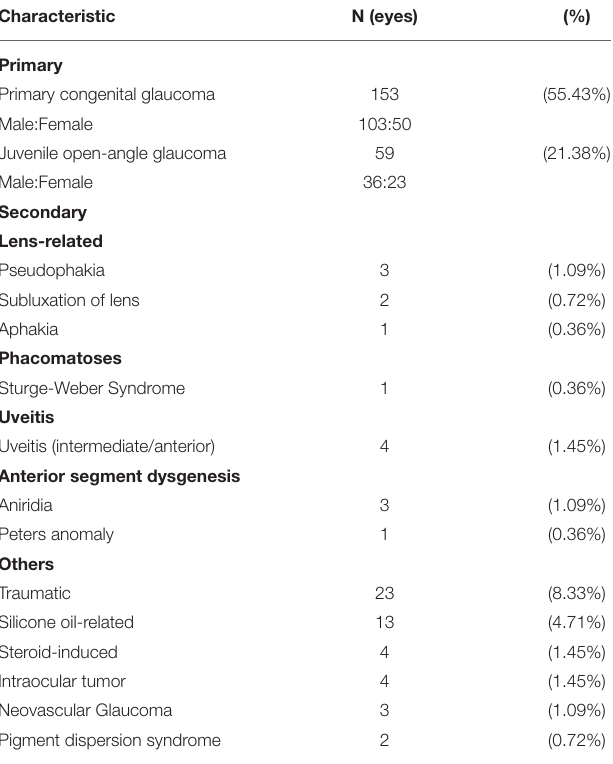
( Table 4 ). Eyes with lens-related glaucoma received intraocular lens (IOL) repositioning, IOL suspension fixation, and IOL extraction. Four retinoblastoma eyes received